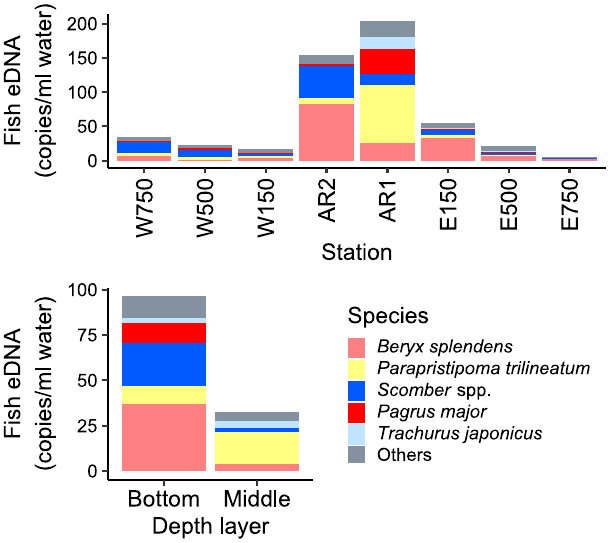
Figure 5. Barplots of fish composition of dominant OTUs. Different colors indicate different OTUs.